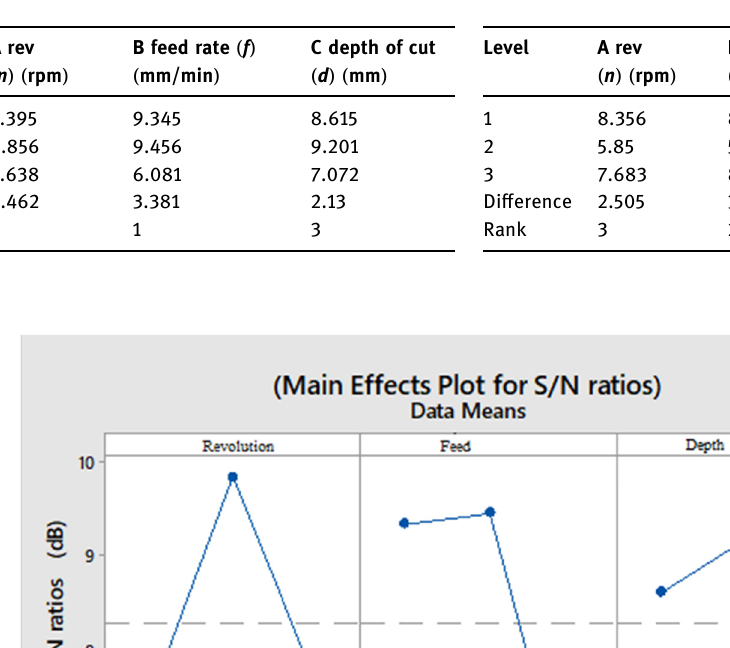
Table 6: S/N ratios of surface roughness values